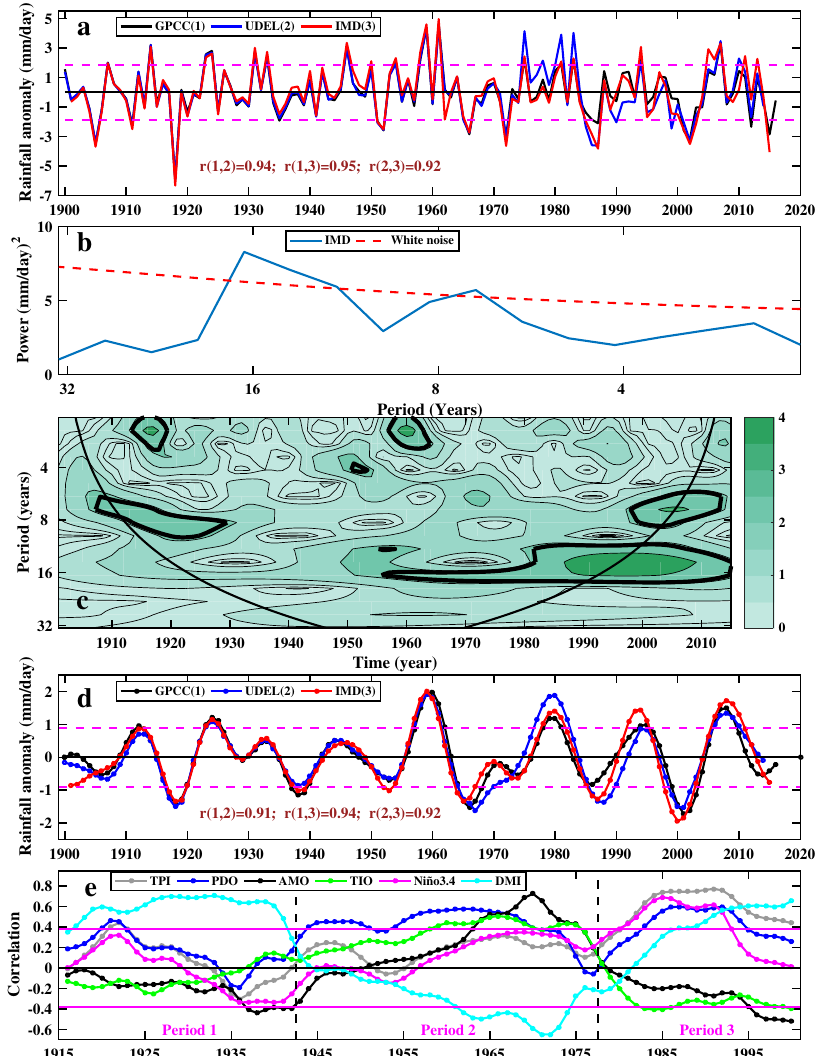
Fig. 2 Temporal evolution of rainfall variability over WG. a Time-series of summer monsoon rainfall anomaly (mm/day) over the Western Ghats (WG) from different rainfall datasets. Dashed lines indicate ±1 std of rainfall anomaly over the WG from IMD. b Power spectrum of IMD rainfall anomaly of WG. The dashed line displays white noise spectrum at 90% con fi dence level. c Wavelet spectrum of IMD rainfall anomaly of WG. Black thick solid line contours indicate signal quali fi es 90% con fi dence level. d 9 – 30 years bandpass fi ltered summer monsoon rainfall anomaly (mm/day) over the WG from different datasets. Dashed magenta color lines are ±1 std of fi ltered rainfall anomaly from IMD. e 31- years running correlation of 9 – 30 years bandpass fi ltered WGI with different fi ltered SST indices manifest major climate variability over the different parts of the global ocean. The solid magenta line represents the 90% con fi dence level for the correlation. 1998 – 2012; in the recent period, decadal to multidecadal rainfall datasets and con fi rming the robustness of the WG rainfall variability. Figure 2b shows the power spectrum of WGI from IMD variability in 12 – 20-year time period is dominant during 1956 to rainfall. The red dashed line shows white noise with 90% 2015. Above spectrum and wavelet analysis is the basis to apply con fi dence. Spectrum analysis of WGI shows two peaks crossing 9 – 30 years bandpass fi ltered to WGI from GPCC, UDEL, and IMD the 90% con fi dence level; corresponding periods of peaks are 7 datasets for extracting decadal and multidecadal signals (Fig. 2d). years and 12 – 20 years (with maximum strength at 17 years), Similar to interannual variability (Fig. 2a), decadal variability respectively, con fi rming the decadal and multidecadal variability strength is high after 1955 compared to the earlier period. The when considering the entire time-series. Figure 2c shows the horizontal dashed magenta lines show ±1 standard deviation for wavelet analysis of WGI, where the y -axis is frequency/period and the index from the IMD dataset. Those years when WGI is greater/ the x -axis is time; different color shades display the strength of the smaller than one standard deviation are considered extremes; for signal of a particular frequency at that time. However, it is crucial positive they are excess years, and for negative they are de fi cit to know whether the strength of frequency is statistically years. Figure 2d also shows the correlation between different signi fi cant or not, for which white noise spectrum analysis is datasets for WGI decadal to multidecadal variability, and it has a applied at a 90% con fi dence level. The black thick line contour correlation of 0.91, 0.94 and 0.92 for GPCC-UDEL, GPCC-IMD, and displayed in Fig. 2c indicates the strength of this frequency/period UDEL-IMD respectively. Individual SST indices with WGI are shown is qualifying the signi fi cant test. According to which, 6 – 10-year as Supplementary Fig. 3. period was signi fi cant during 1908 – 1930 and also during npj Climate and Atmospheric Science (2022)